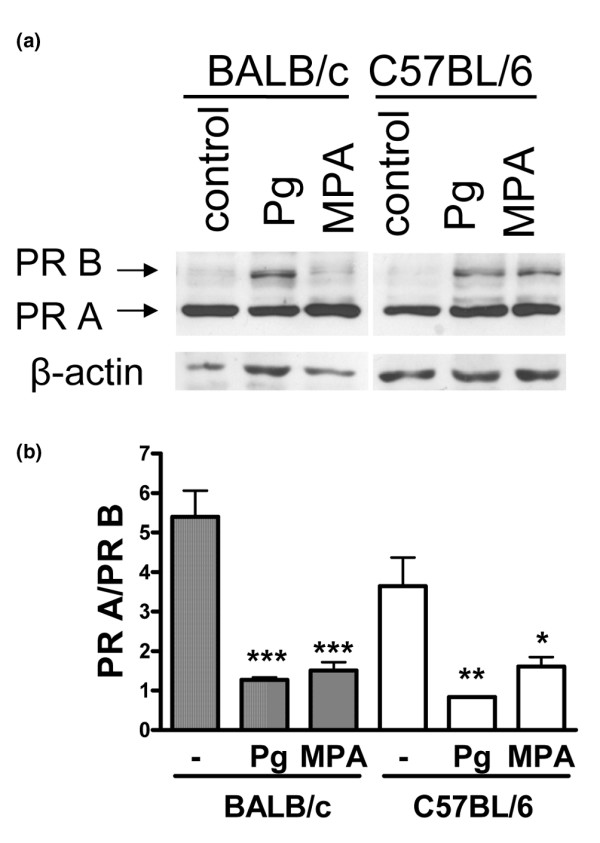
PR expression in mammary glands treated with progestins for 2 months: Western blot studies. Mammary glands from the same groups shown in Figure 4 were processed to obtain nuclear extracts (as explained in Materials and methods) and used in Western blots. (a) A representative experiment using C-19 PR Santa Cruz antibody is shown. Because different amounts of epithelial cells are present in the different extracts, the (b) ratio of PR-A/PR-B in three different experiments is shown. *P < 0.05, **P < 0.01, ***P < 0.001 treated versus control. PR, progesterone receptor.